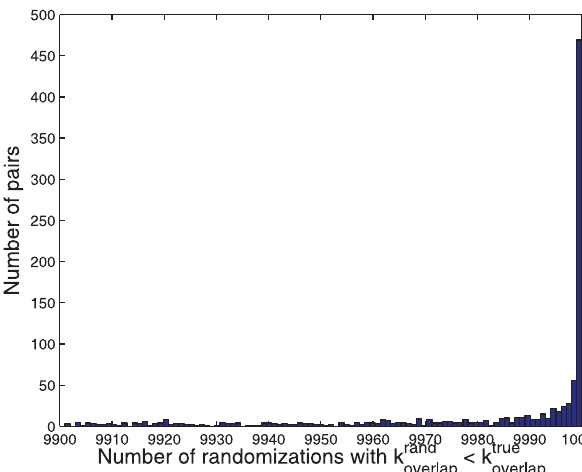
Figure 8. Histogram Representing Bootstrap-Estimated p -Values for Bi- Fan Array